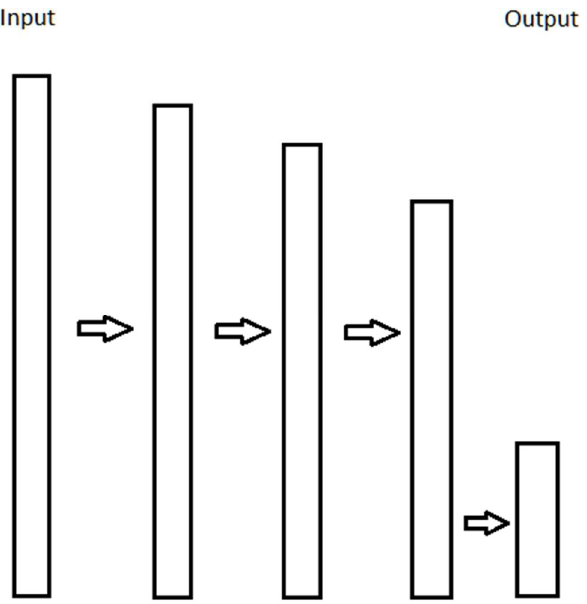
Figure 6. Abstract diagram of layers of a neural network that contain information. It is a closed system and the information flows from input to output. The information content from one layer to the next can stay the same or decrease, but not increase, because information moves by a physical process, and therefore is constrained by the Laws of Thermodynamics.